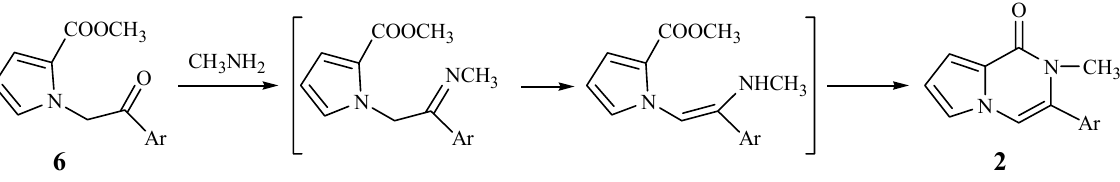
Figure 1. Proposed mechanism of the first cyclization